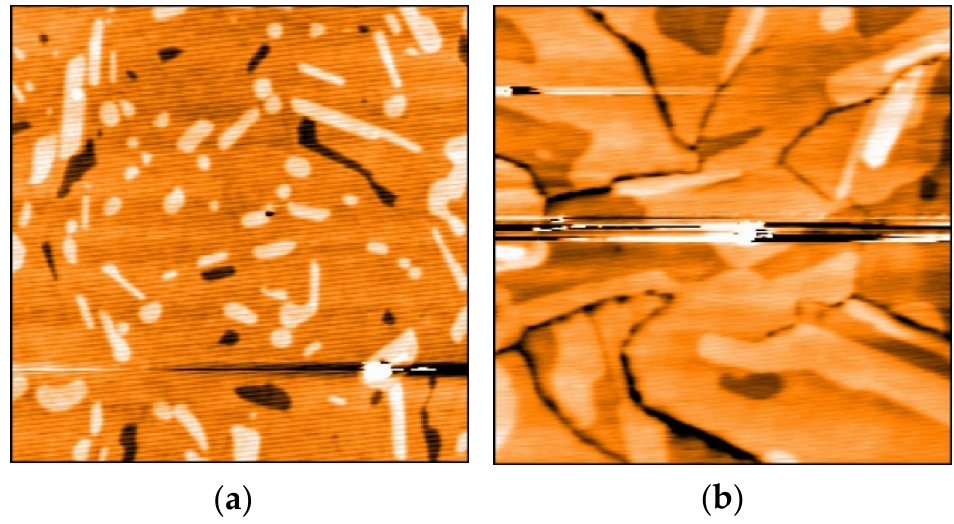
Figure 7. AFM images (5 µm × 5 µm) of OSC film deposited SiO 2 /HMDS at ( a ) 90 °C and ( b ) 120 °C. Table 2. Model parameters extracted for OTFTs in BG configuration on SiO 2 /HMDS insulator for different substrate temperatures during OSC deposition.